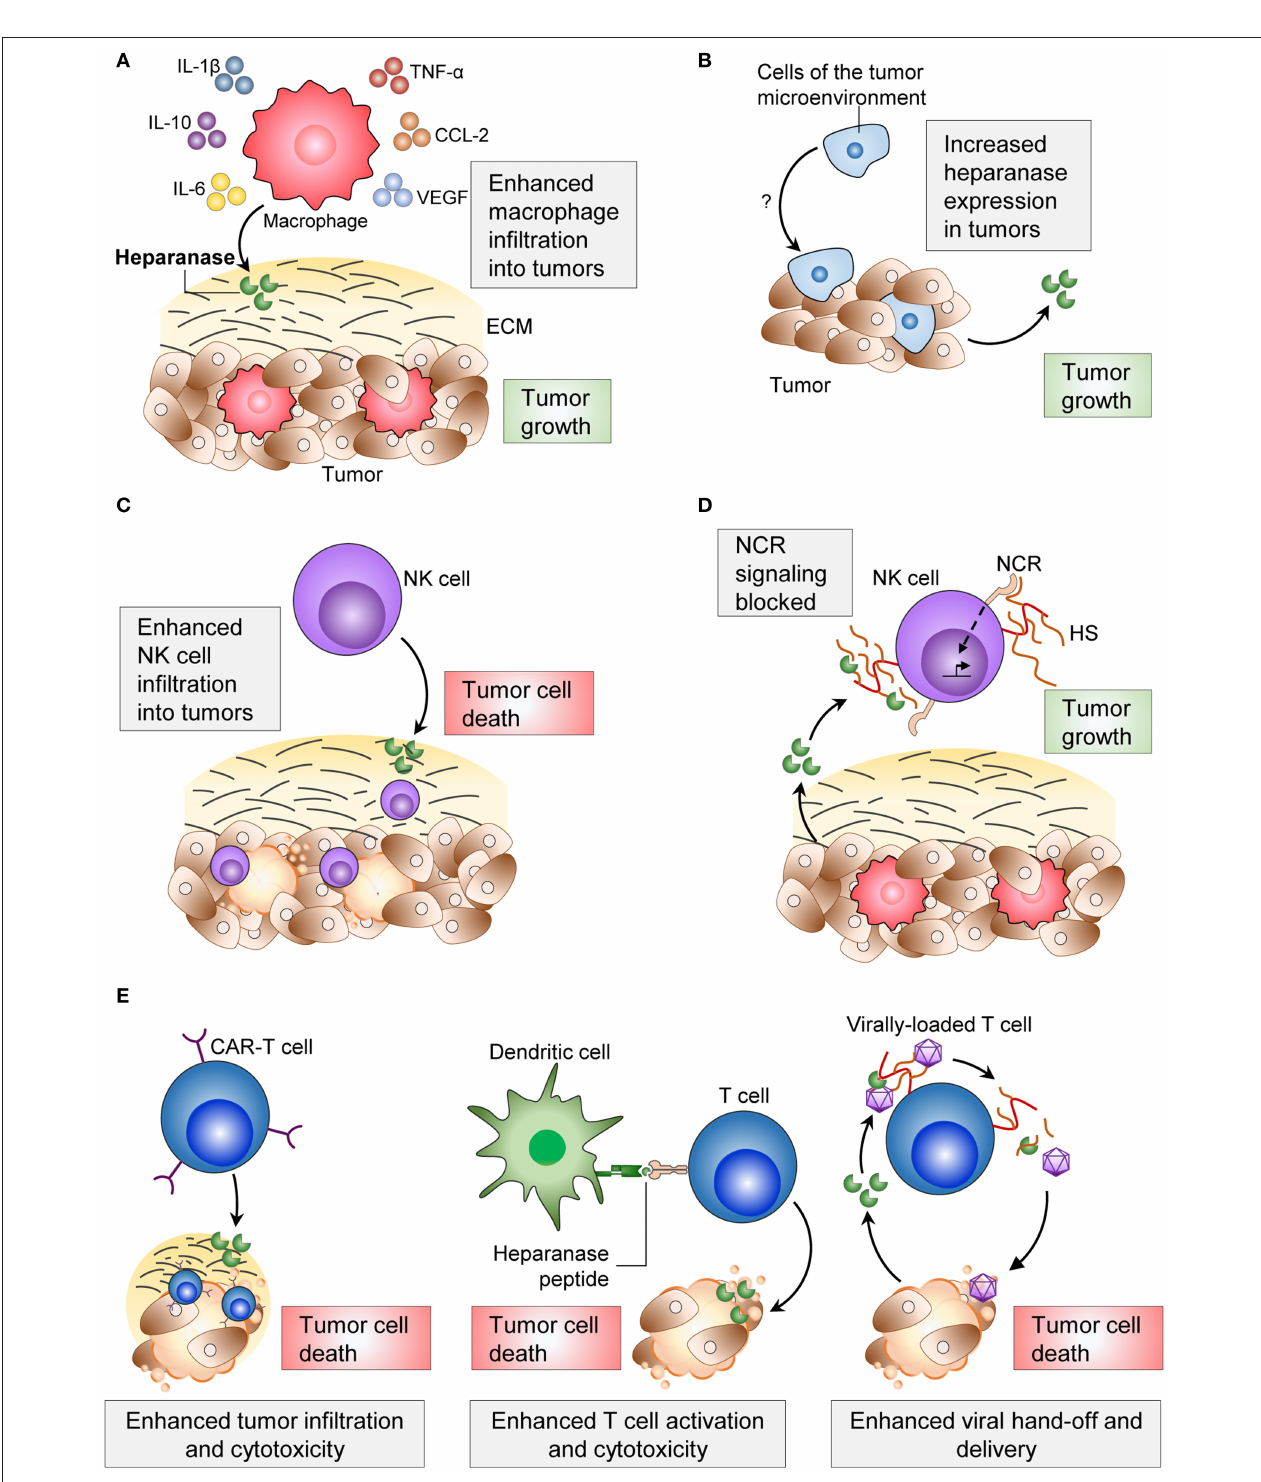
FIGURE 1 | Effects of heparanase on immune cells and the consequences on tumor progression. (A) Heparanase from macrophages and from tumor cells increase macrophage infiltration into tumors, cytokine secretion and phagocytic ability. (B) Cells of the tumor microenvironment increase tumor cell-heparanase and increase tumor cell proliferation. (C) Heparanase enhances NK cell infiltration into tumors and consequent tumor cell clearance. (D) Tumor cell-heparanase can block NCR signaling and consequent activation of NK cells. (E) Applications of immune cell-heparanase include use in CAR T cells, dendritic cell vaccines, and viral delivery of anti-tumorigenic agents. ECM, extracellular matrix; NCR, natural killer cytotoxicity receptor; HS, heparan sulfate; CAR-T, chimeric antigen receptor-T.